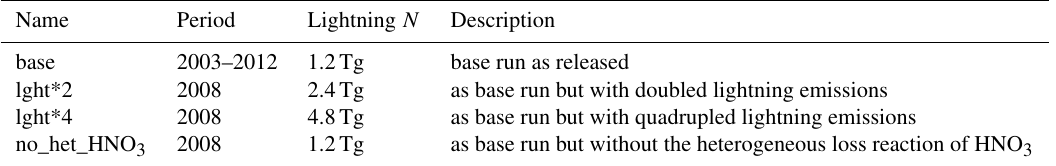
Table 4. Summary of simulations performed for the analysis of global trace gas budgets in this